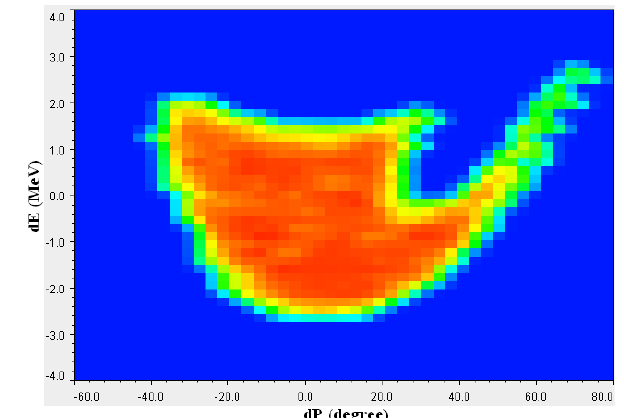
FIG. 5. (Color) Measured beam loss for beams within and out of the longitudinal acceptance. Each BLM recorded two signals, and beam power dumped in the SCL is approximately 0.5 W.